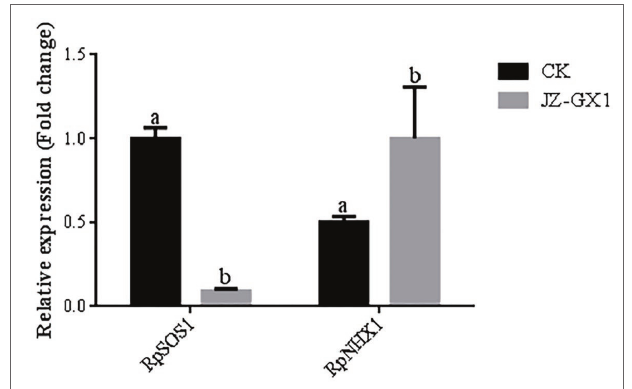
FIGURE 5 | Effect of volatile gas produced by R. aquatilis JZ-GX1 on the expression of RpSOS1 and RpNHX1 in R. pseudoacacia root